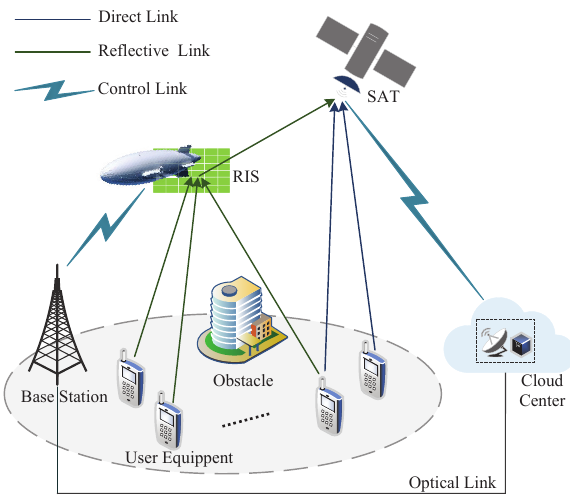
Figure 1. Illustration of a RIS-assisted IS-HAP-TNs